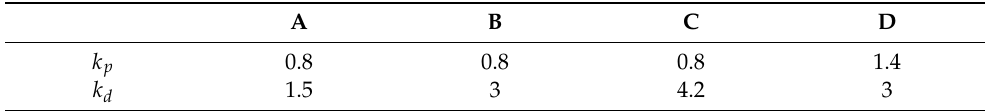
Table 1. k p − k d